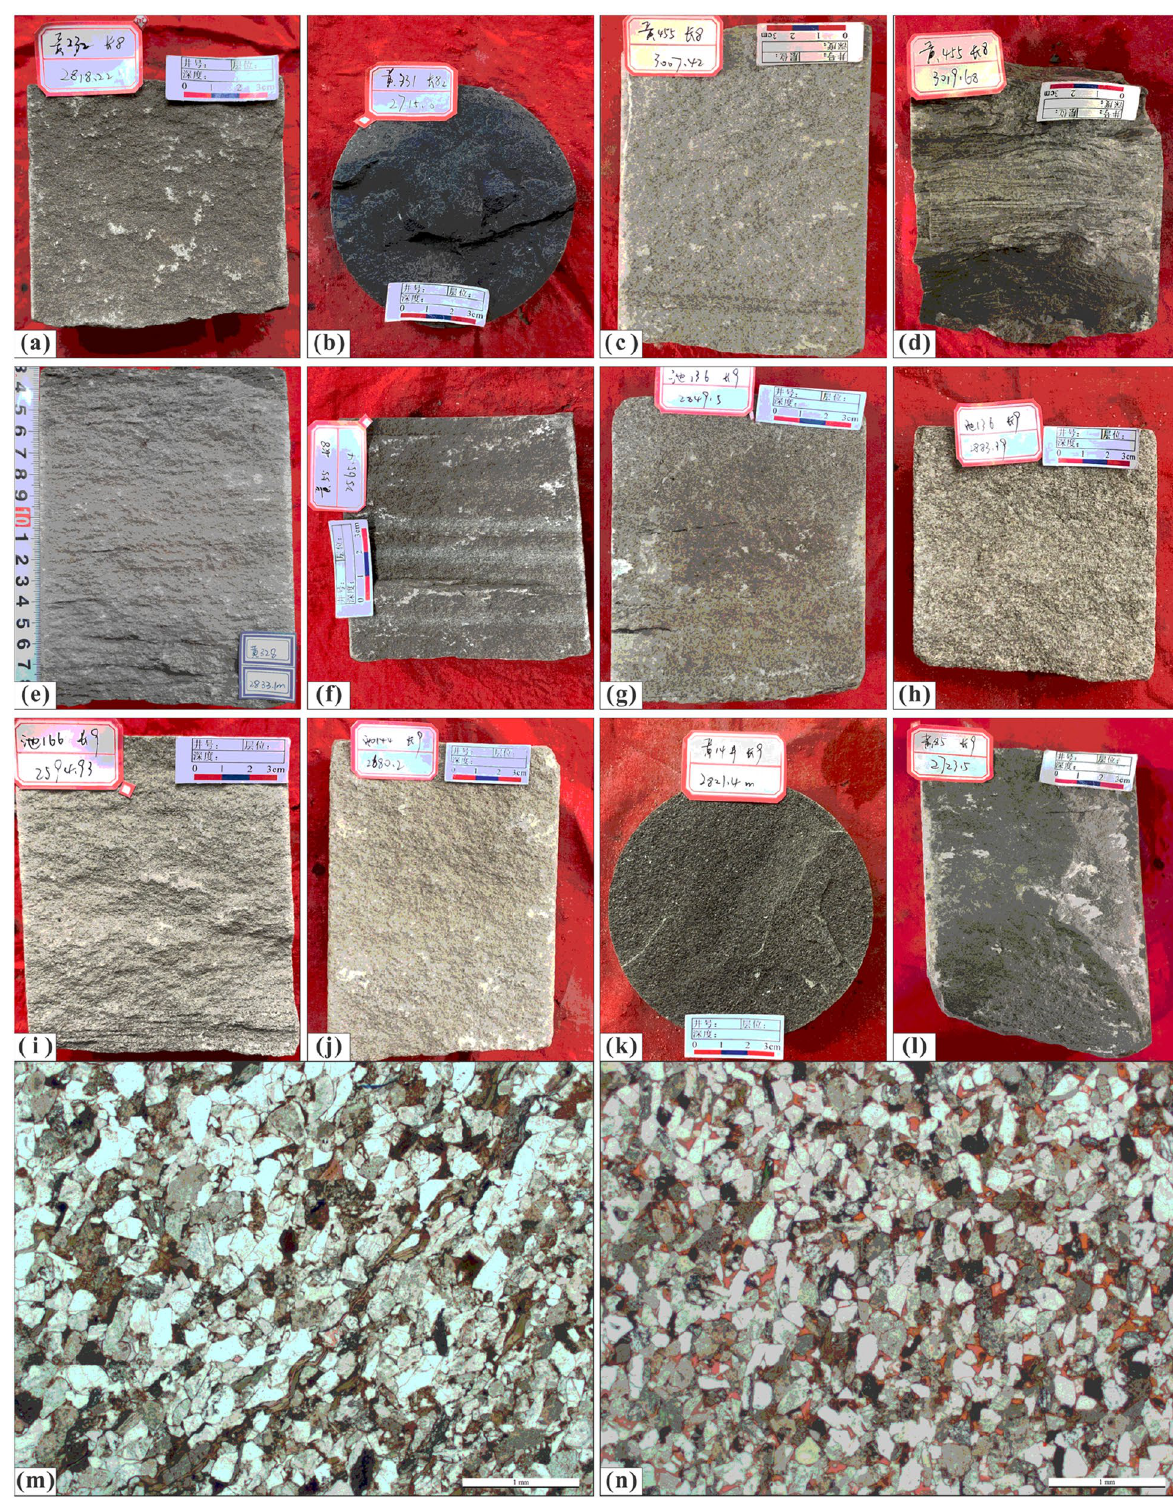
Figure 4. Lithologic and colour characteristics. Note ( a ) Grey ‒ brown oil-bearing fine sandstone, Well Huang-232, Chang 8 2 , 2818.22 m; ( b ) Grey ‒ black mudstone, Well Huang-331 Chang 8 2 , 2715.0 m; ( c ) Grey ‒ green fine sandstone, Well Huang-455, Chang 8 2 , 3007.42 m; ( d ) grey ‒ black argillaceous siltstone, Well Huang-455, Chang 8 2 , 3019.68 m; ( e ) off-white fine sandstone, Well Huang-328, Chang 8 2 , 2833.1 m; ( f ) Greyish brown/grey ‒ white fine sandstone, Well Huang-55, Chang 8 2 , 2565.4 m; ( g ) Grey ‒ brown oil-bearing fine sandstone, Well Chi-136, Chang 9, 2849.5 m; ( h ) Grey ‒ brown oil-bearing medium sandstone, Well Chi-136 Chang 9, 2883.39 m; ( i ) off-white fine sandstone, Well Chi- 166 Chang 9, 2594.93 m; ( j ) oil-bearing fine sandstone, Well Chi-144, Chang 9, 2680.2 m; ( k ) Grey ‒ black mudstone, Well Huang-14, Chang 9, 2821.4 m; ( l ) Grey ‒ black siltstone, Well Huang-85, Chang 9, 2723.5 m; ( m ) Thin section, Well Huang-55, Chang 8 2 , 2561.6 m; ( n ) Thin section, Well Huang-431, Chang 9, 2700.3